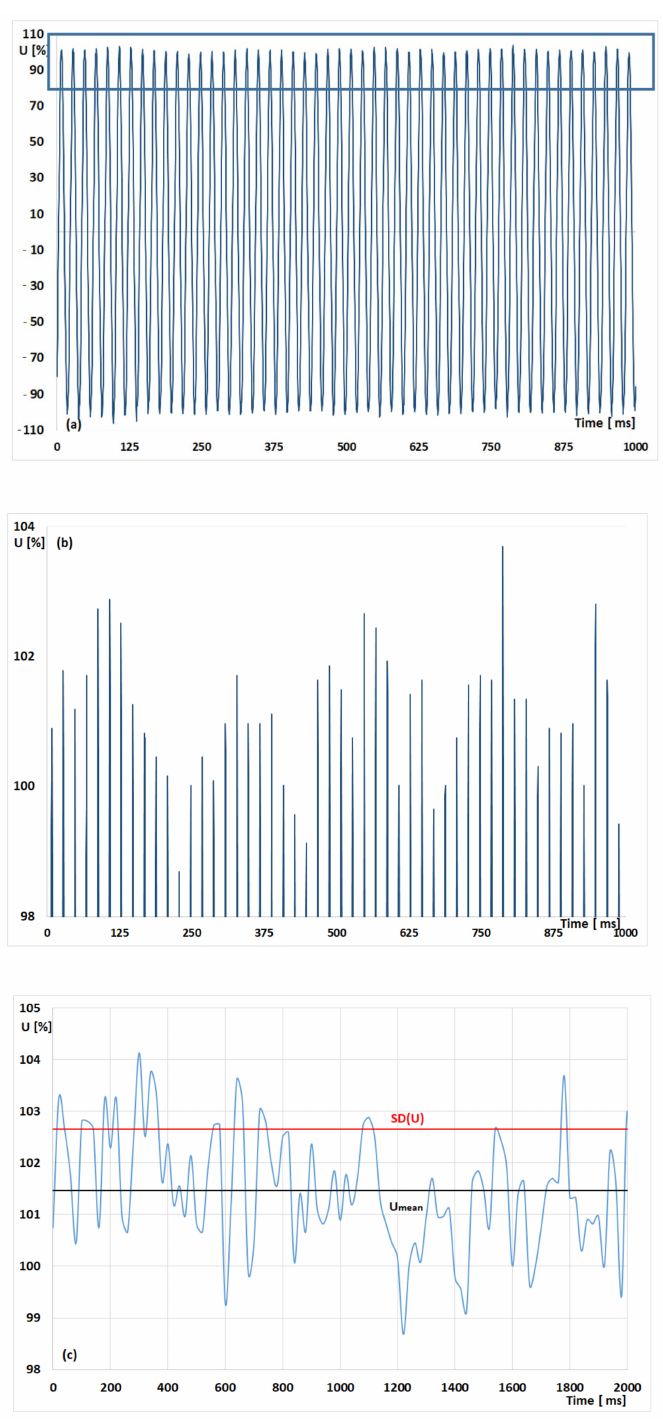
Figure 1. Voltage changes in the supply line to arc furnaces: voltage oscillogram ( a ), maximum values of the oscillogram ( b ), U rms voltage ( c